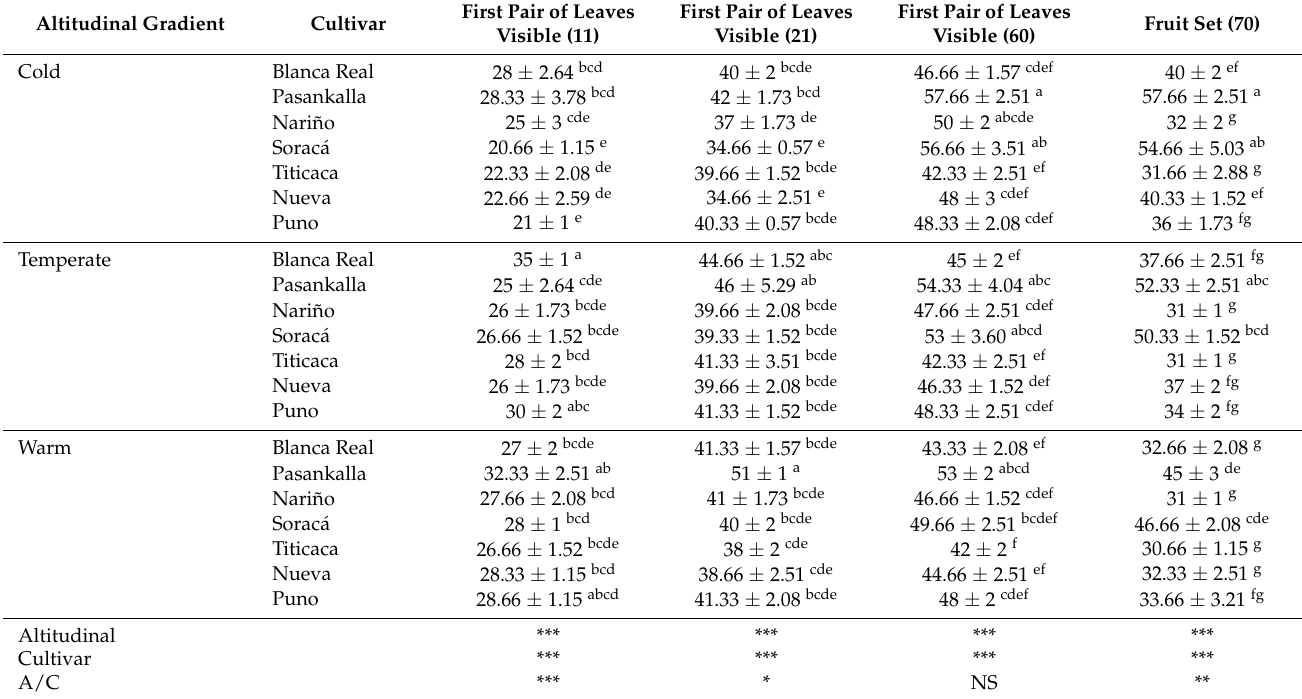
Table 3. Total chlorophyll content (SPAD) in seven quinoa cultivars subjected to three altitude